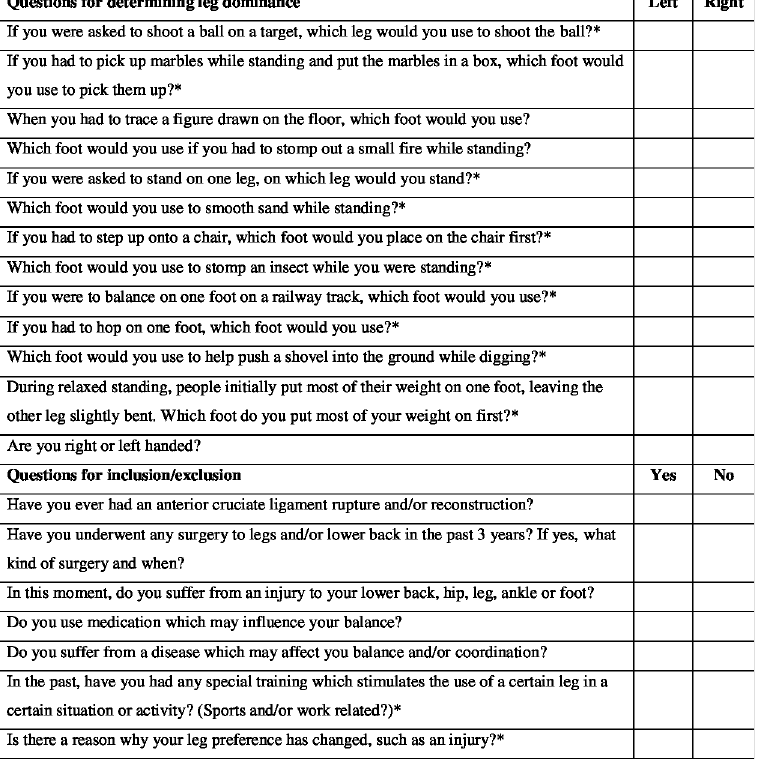
Fig 1. Leg domiance questionaire used in this study. The originalquestionsof the WFQ-R are marked with a * .